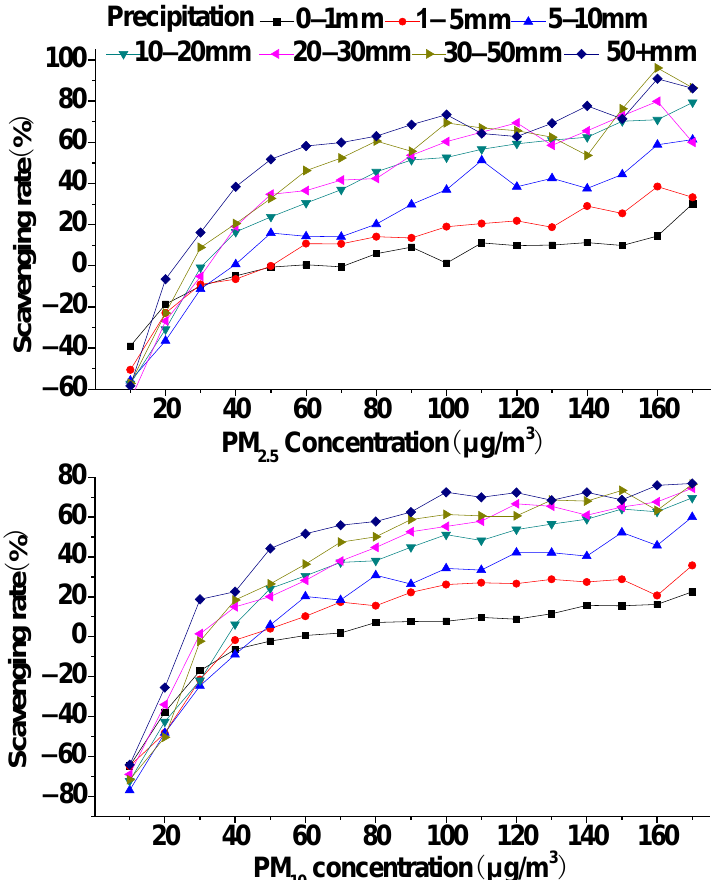
Figure 5. Effect of particle concentration on SR under different precipitation volumes. Rain ranges: 0–1, 1–5, 5–10, 10–20, 20–30, 30–50, >50 mm.